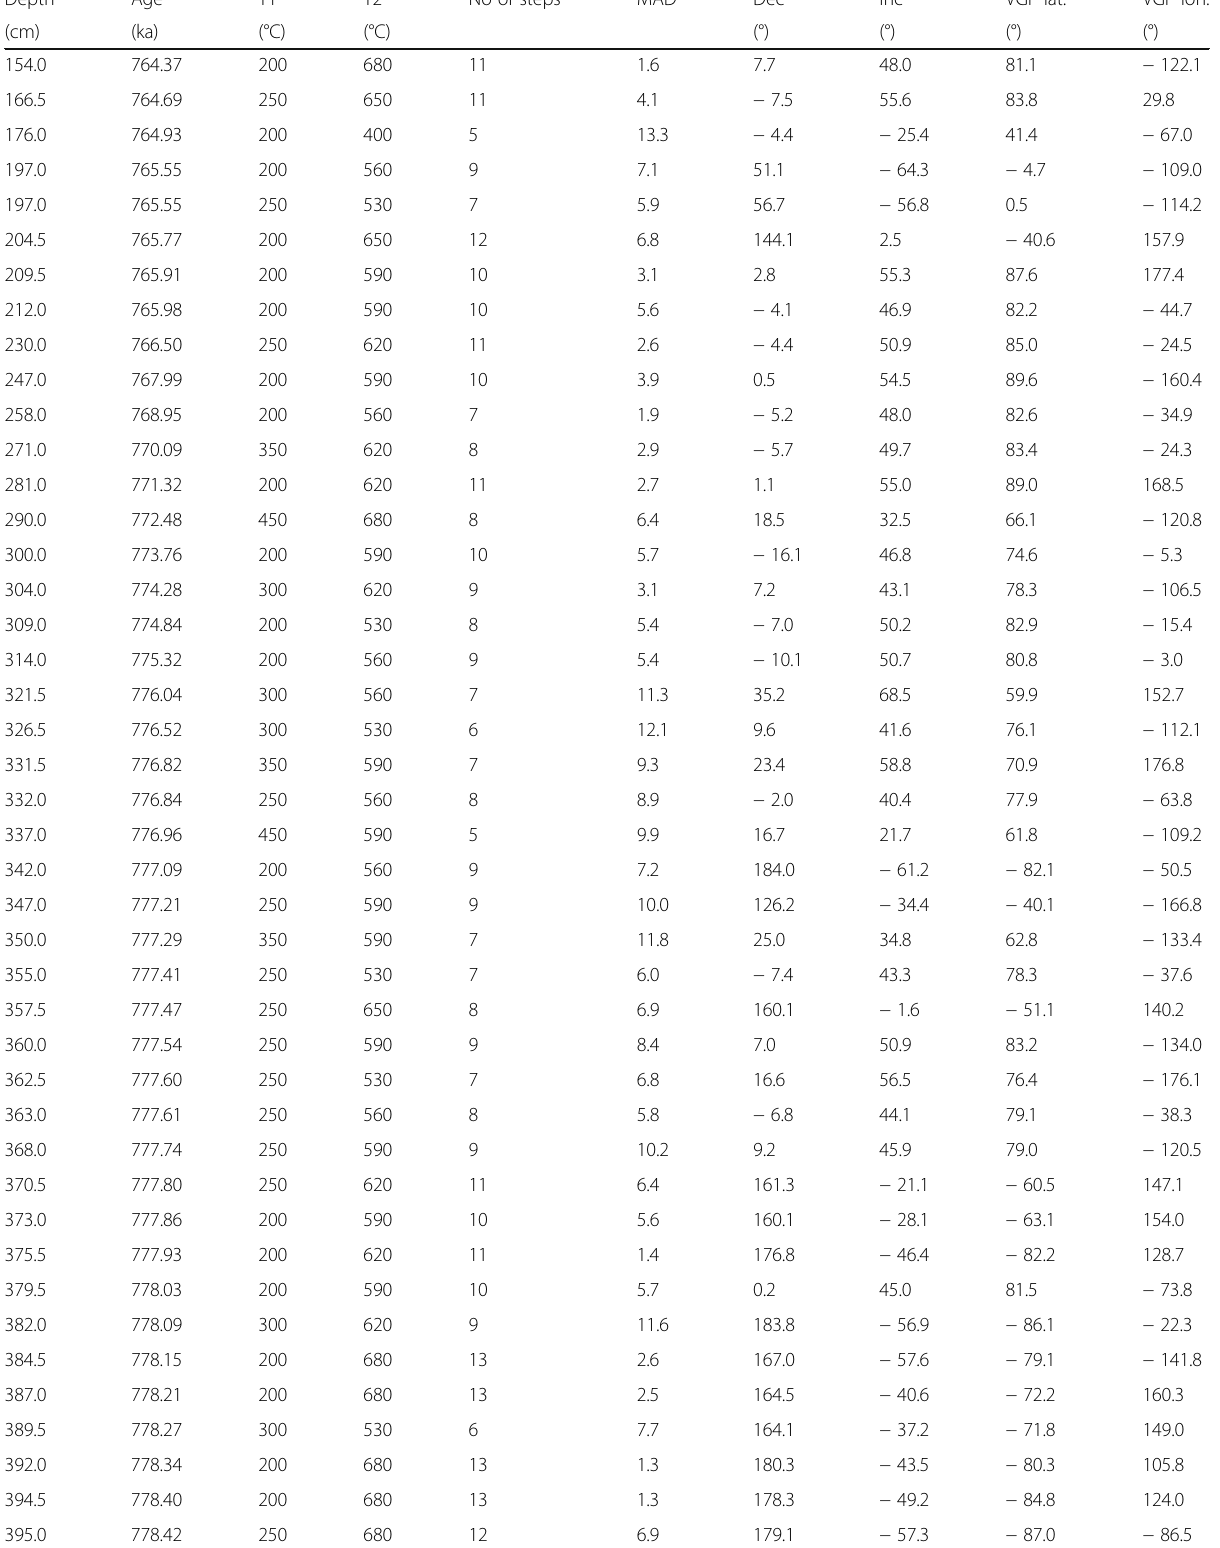
Table 1 Results of paleomagnetic